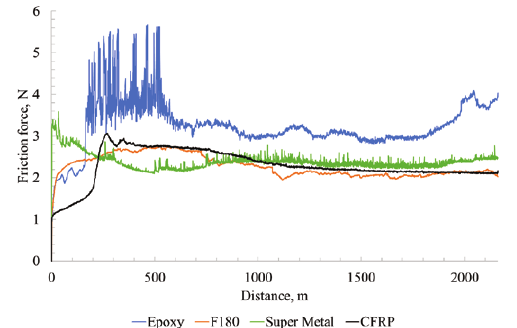
Figure 3 . Friction force during the test for tested materials samples